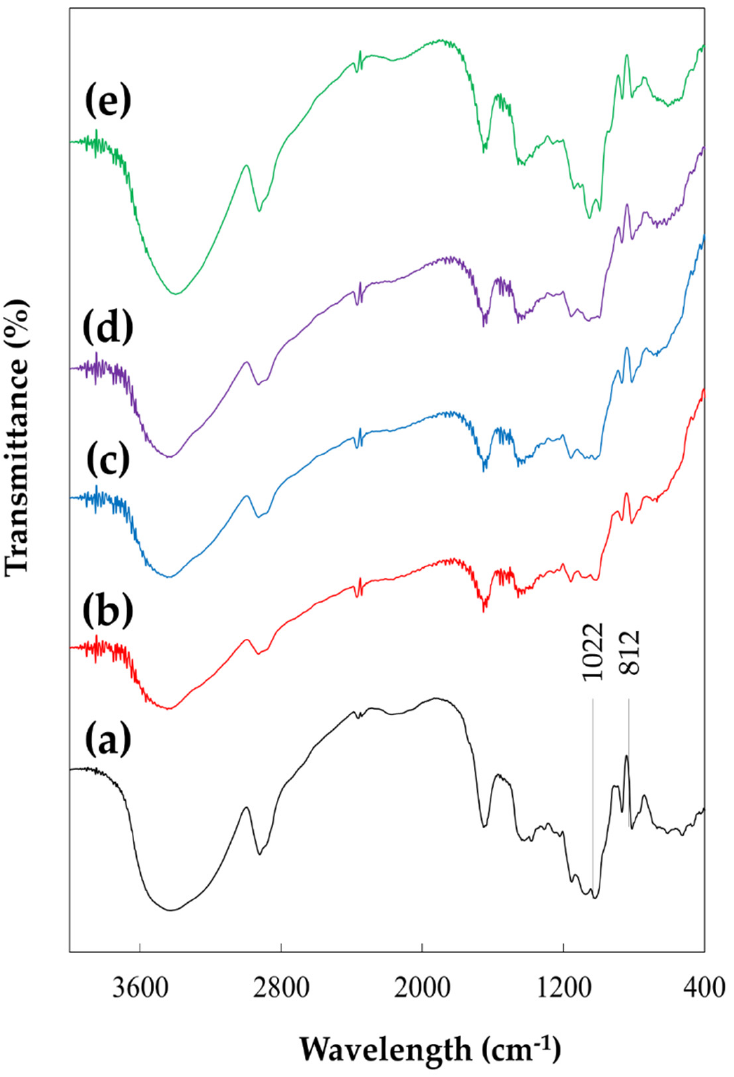
Figure 2. FTIR spectra of ( a ) non-agglomerated and agglomerated guar gum (GG) with various concentrations of sucrose binder: ( b ) GG–0%, ( c ) GG–10%, ( d ) GG–20%, and ( e ) GG–30%.